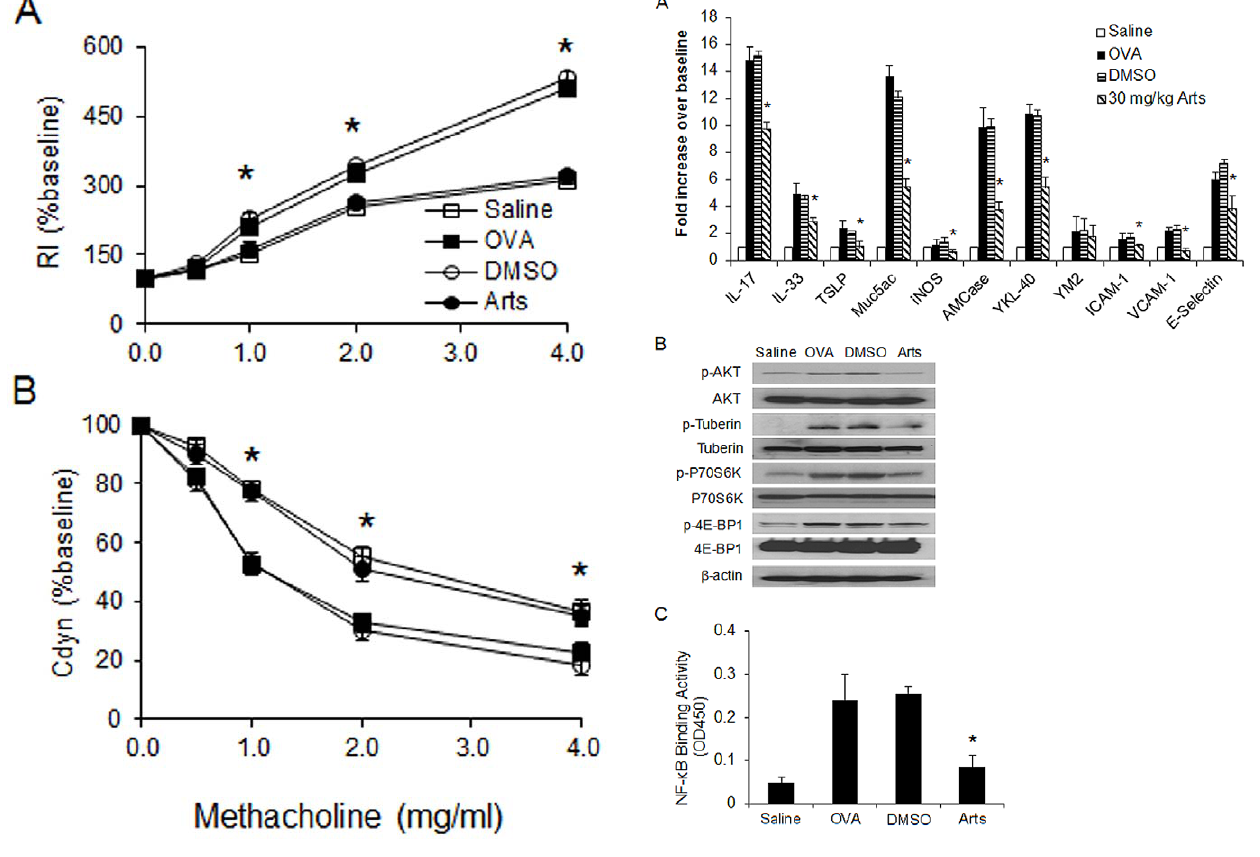
Figure 4. Effects of artesunate on OVA-induced AHR. Airway responsiveness of mechanically ventilated mice in response to aerosolized methacholine was measured 24 hours after the last saline aerosol or OVA aerosol with pretreatment of either DMSO or 30 mg/kg artesunate. AHR is expressed as percentage change from the baseline level of (A) lung resistance (Rl, n=6 mice) and (B) dynamic compliance (Cdyn, n=6 mice). Rl is defined as the pressure driving respiration divided by flow. Cdyn refers to the distensibility of the lung and is defined as the change in volume of the lung produced by a change in pressure across the lung. *Significant difference from DMSO control, p , 0.05.